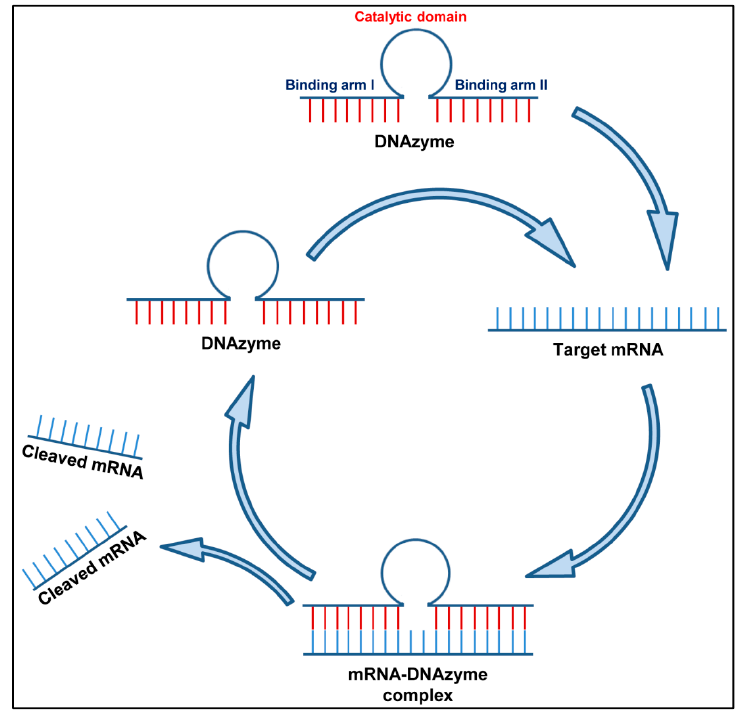
Figure 3. Mechanism of action of DNAzyme: A DNAzyme has two binding arms designed to bind to the complimentary RNA targets in a Watson – Crick pairing. The DNAzyme binds to its target mRNA and makes an mRNA–DNAzyme complex. The catalytic motif of the DNAzyme then cleaves its target RNA into pieces, thus inhibiting gene expression. After cleaving the RNA target, the DNAzyme becomes free again to enter into the next cycle.